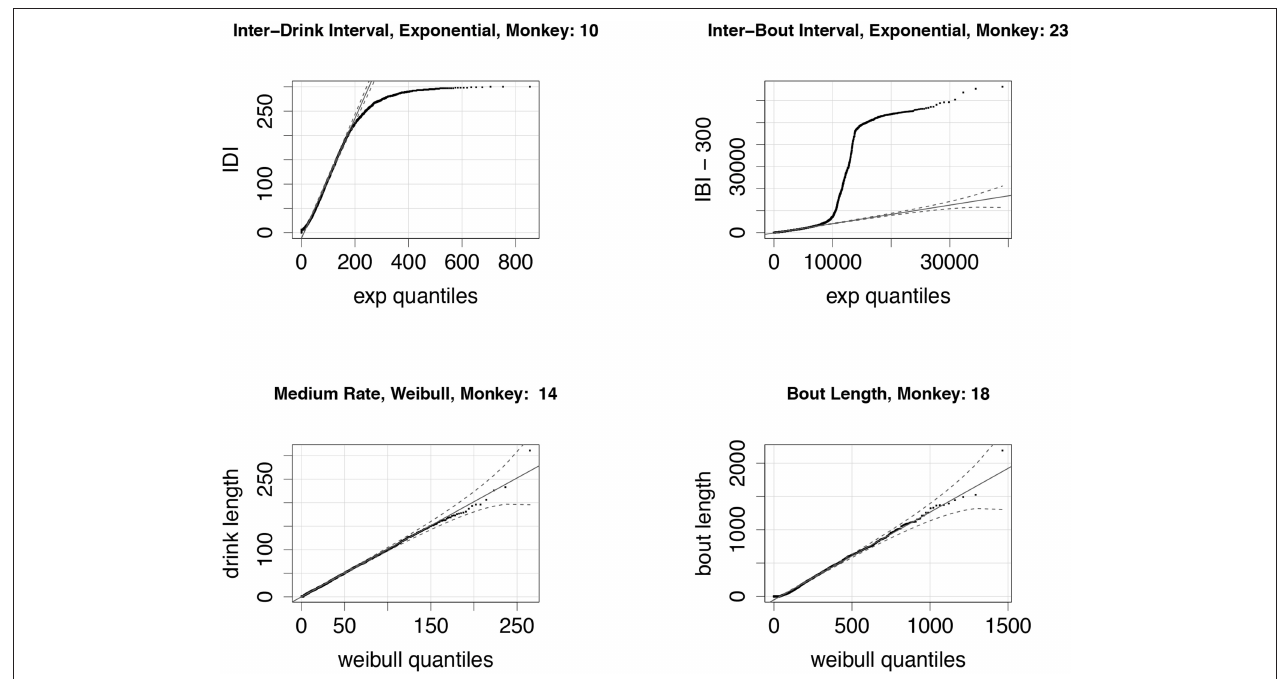
FIGURE 4 | (Top Left) : A quantile-quantile (q-q) plot of the distribution of experimentally derived inter-drink intervals against the best-fit exponential distribution; note that inter-drink intervals are always less than 300 s, explaining the deviation from the exponential quantiles at the high end. This particular monkey (ID # 10) is classified as a heavy drinker. (Top Right) A q-q plot of the distribution of experimentally derived inter-bout intervals against the best-fit exponential distribution. Inter-bout intervals are all greater than 300 s, so we subtract 300 from all data points before fitting (these shifted data points are shown here). The sharp vertical deviation of the plot from the fitted quantile plot from ca. 9000 s (2.5 h) and 45,000 s (12 h) suggests that this monkey (ID # 23) took very few drinks during the night-time. This is consistent with the monkey’s classification as a light drinker. (Bottom Left) A q-q plot of drink lengths of a heavy drinker (ID # 14), when drinking at medium rate. The distribution fits a Weibull very well for all drink lengths. (Bottom Right) The bout lengths for a light drinker (ID # 18) also fit a Weibull distribution quite well for a range of bout lengths.